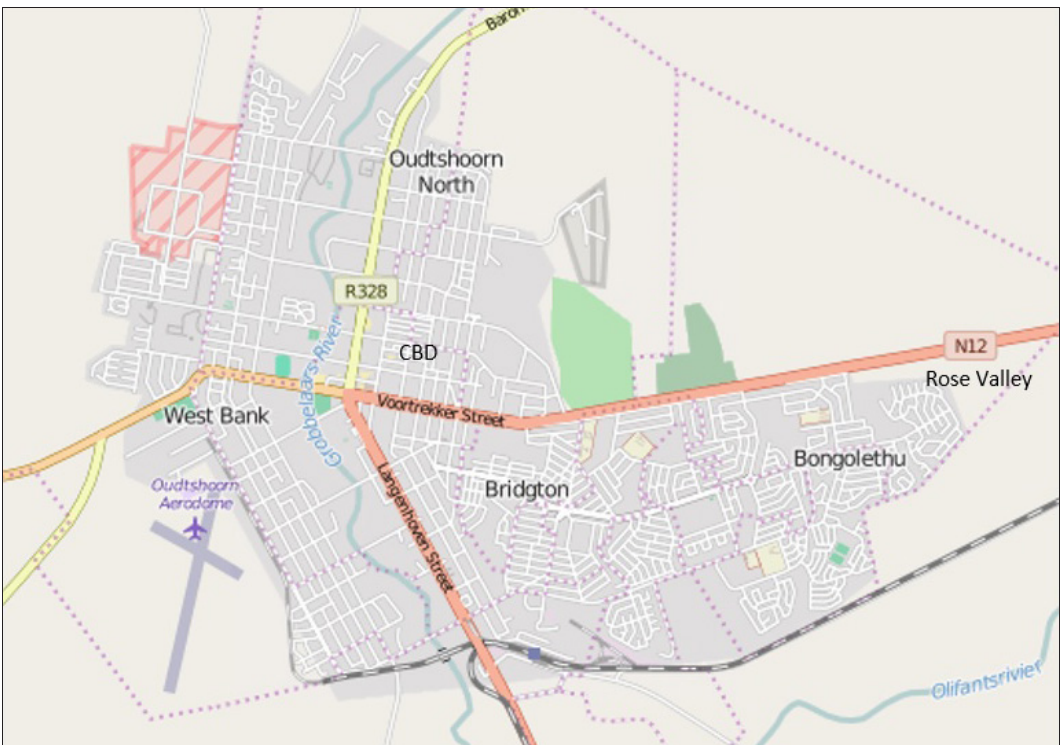
Figure 2: The spatial layout of Oudtshoorn